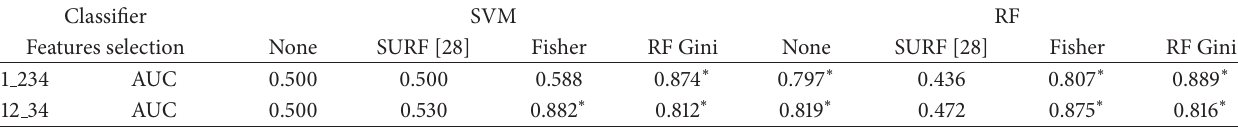
Table 7: Quality robustness assessment (AUC) for screening.